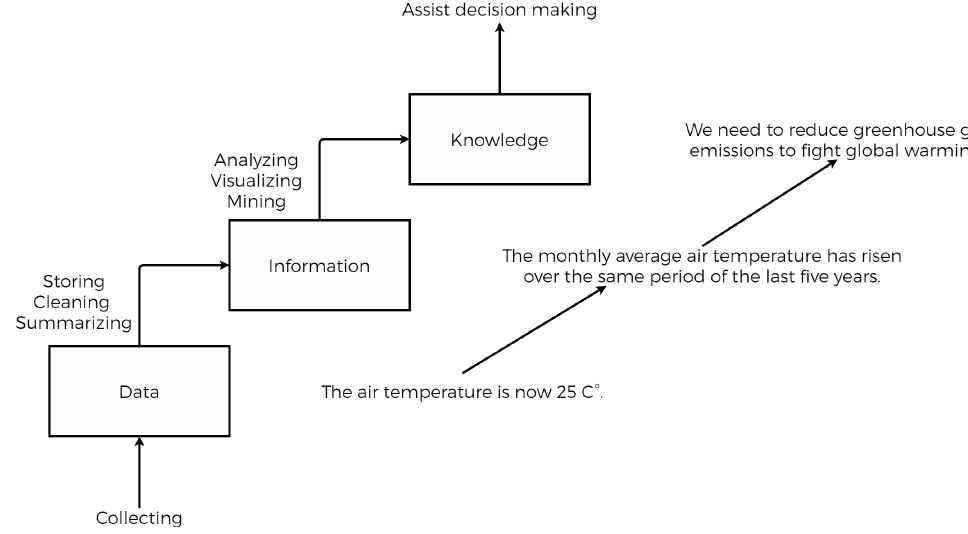
Figure 12. An example of the data analysis